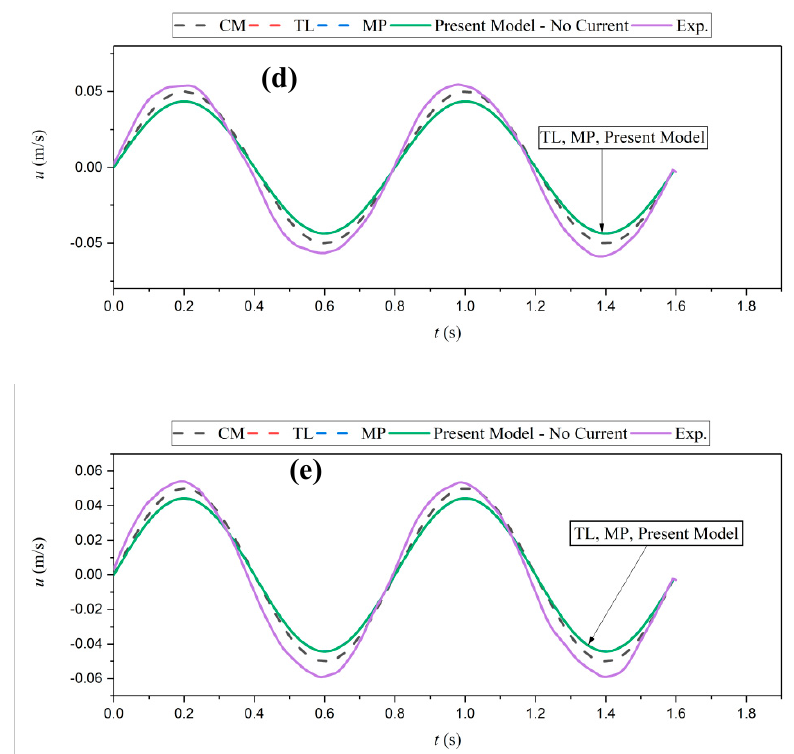
Figure 12. Time series of velocity for T = 0.8 s, H = 0.04 m, W = 130%; ( a ) 0.02 m; ( b ) 0.05 m; ( c ) 0.085 m; ( d ) 0.12 m; ( e ) 0.135 m above the rigid bed.